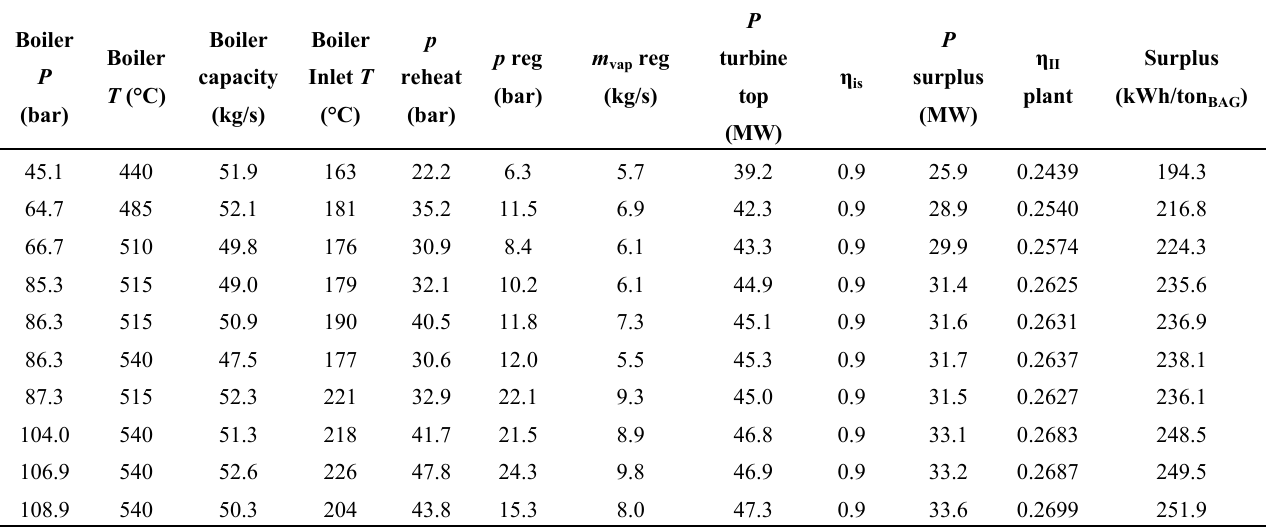
Table 6. Results of optimization for repowering Option 2 with diverse boiler conditions.